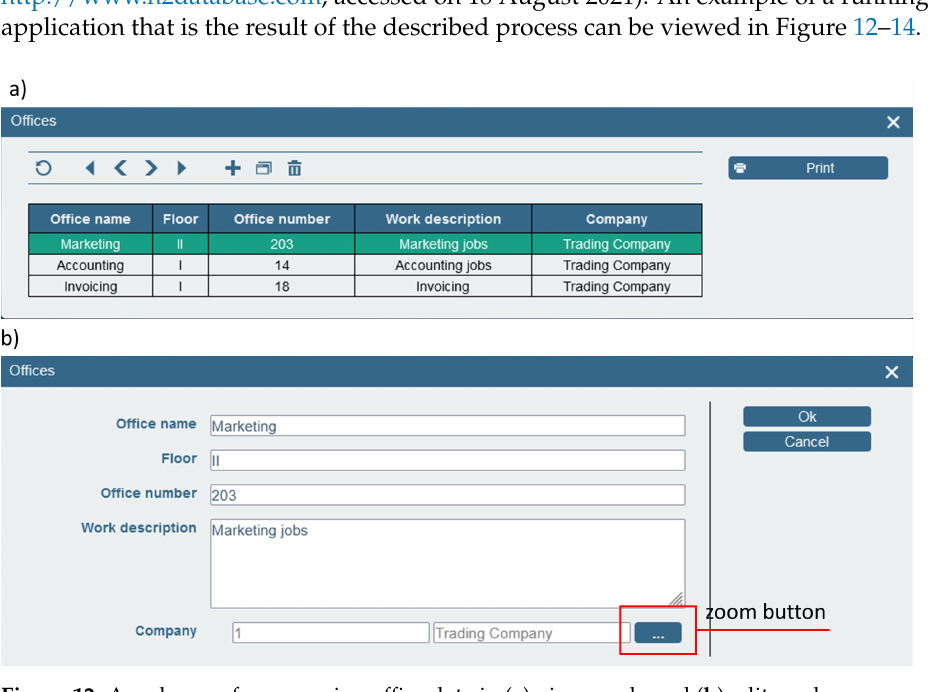
Figure 12. A web page for managing office data in ( a ) view mode and ( b ) edit mode.